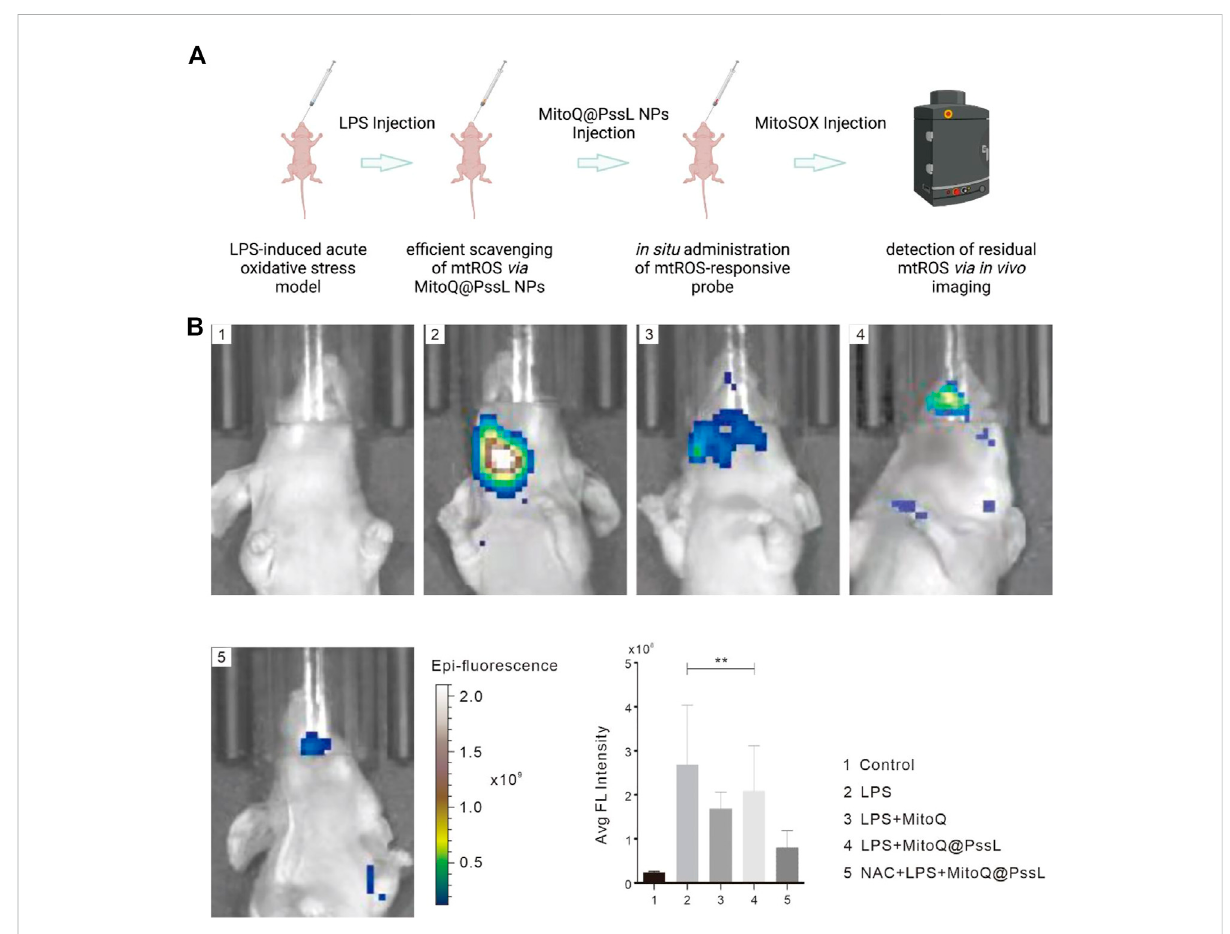
FIGURE 5 Scavenging ef fi ciencies of LPS-induced acute oxidative stress model in BALB/c nude mice. (A) Schematic illustration of LPS-induced periodontal disease in BALB/c nude mice and relative experimental design of mtROS scavenging. (B) Fluorescence imaging of mtROS scavenging capacity and relative quantitative information. (** means p <